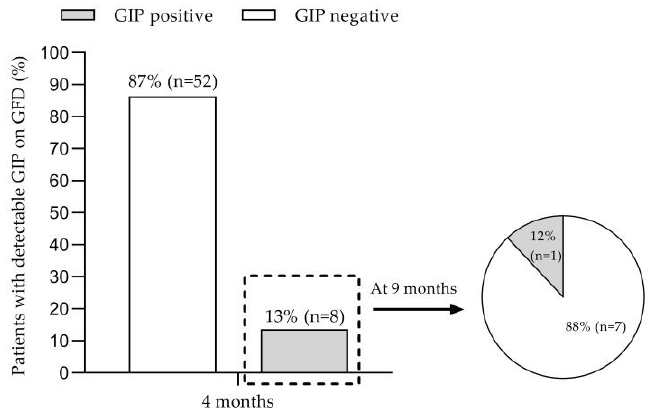
Figure 1. Stool gluten immunogenic peptide detection according to months following a gluten-free diet. GFD, gluten-free diet.